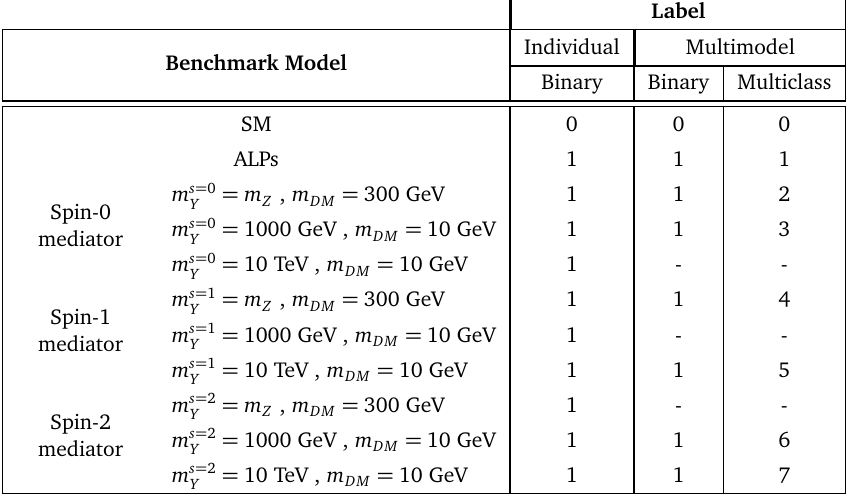
Benchmark Model